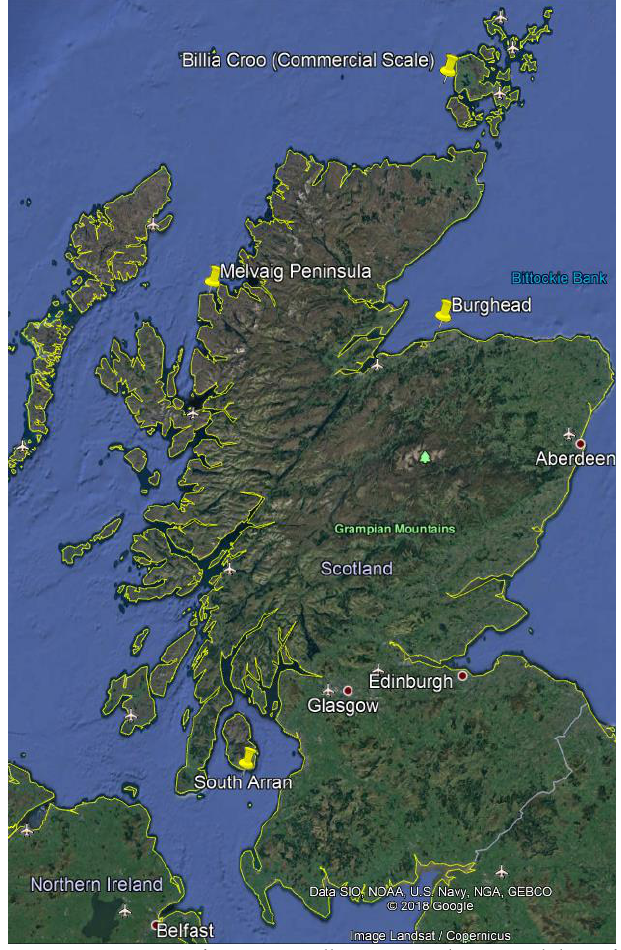
Fig 1. Location of regions (yellow pins) where suitability of resource for a scale site has been